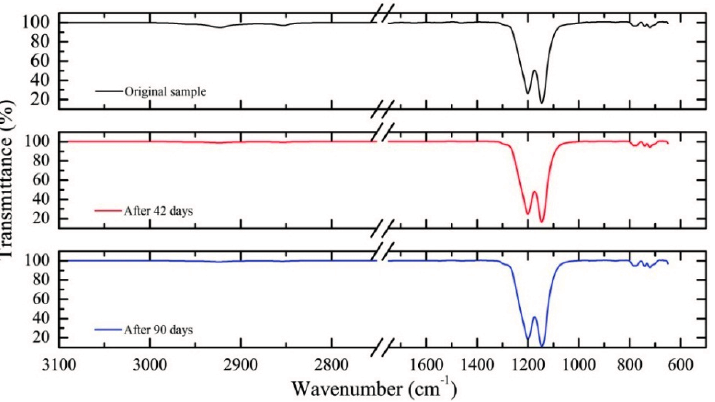
Figure 2. Transmission infrared spectroscopy for PTFE samples immersed in oil: initial ( top ), after 42 days ( middle ) and after 90 days ( bottom ).